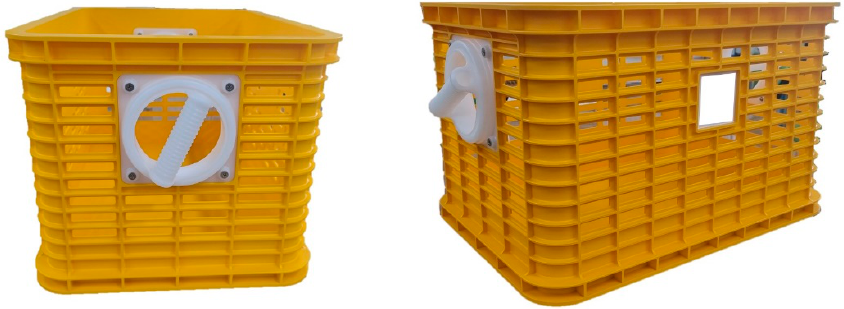
Figure 1. Harvesting baskets with rotational handles (RHB).